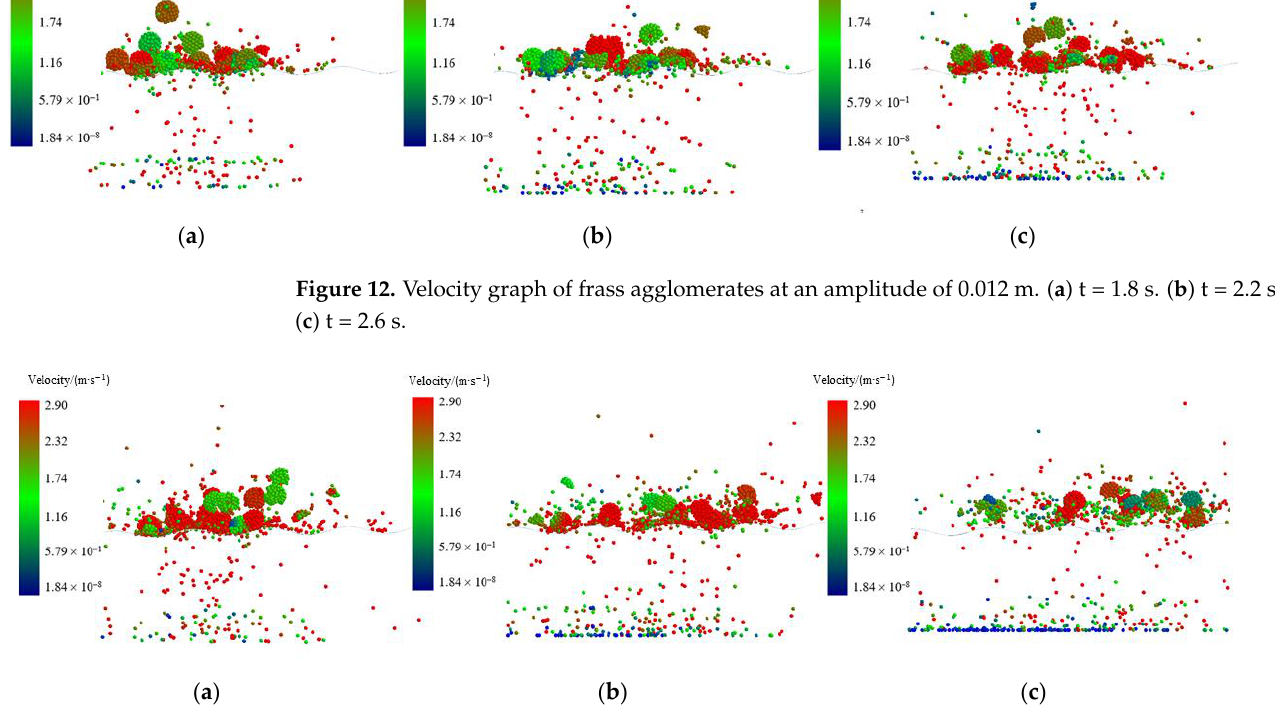
Figure 13. Velocity graph of frass agglomerates at an amplitude of 0.013 m. ( a ) t = 1.8 s. ( b ) t = 2.2 s. ( c ) t = 2.6 s.